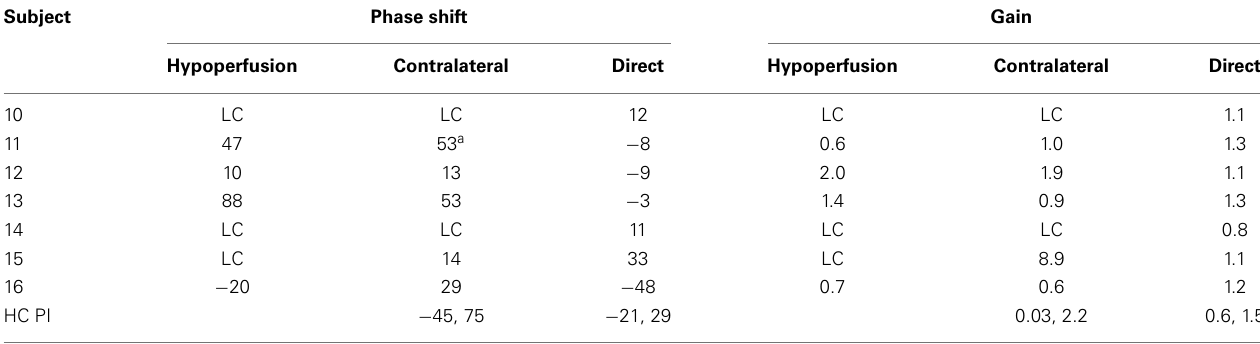
Table 2 | Phase shift and gain values for the patients with global hypoperfusion (sub 10 and 11), the patients without stenosis and occlusion (sub 12–14), patients that were treated with EC-IC bypass before examination (sub 15–16) and prediction intervals for healthy